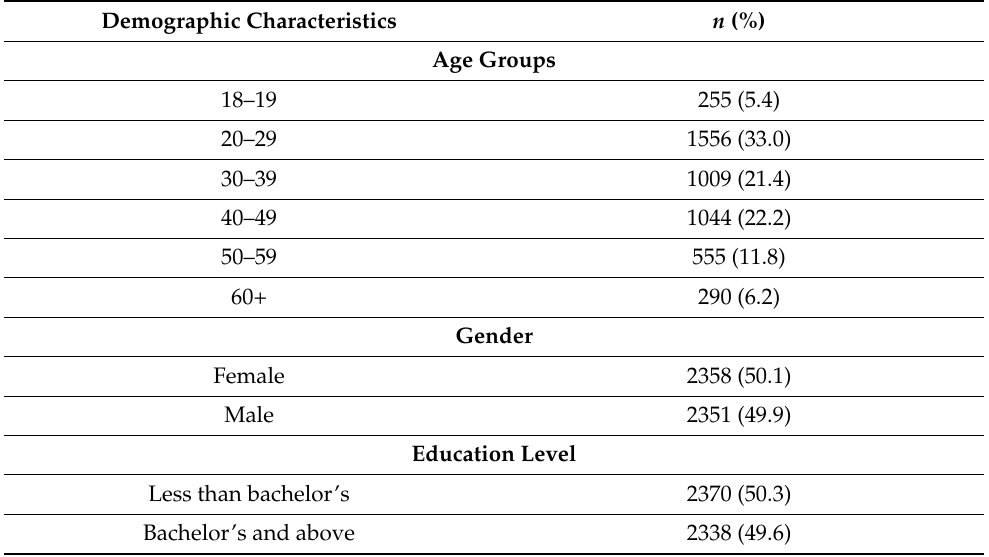
Table 1. Demographic characteristics of participants ( n = 4709).